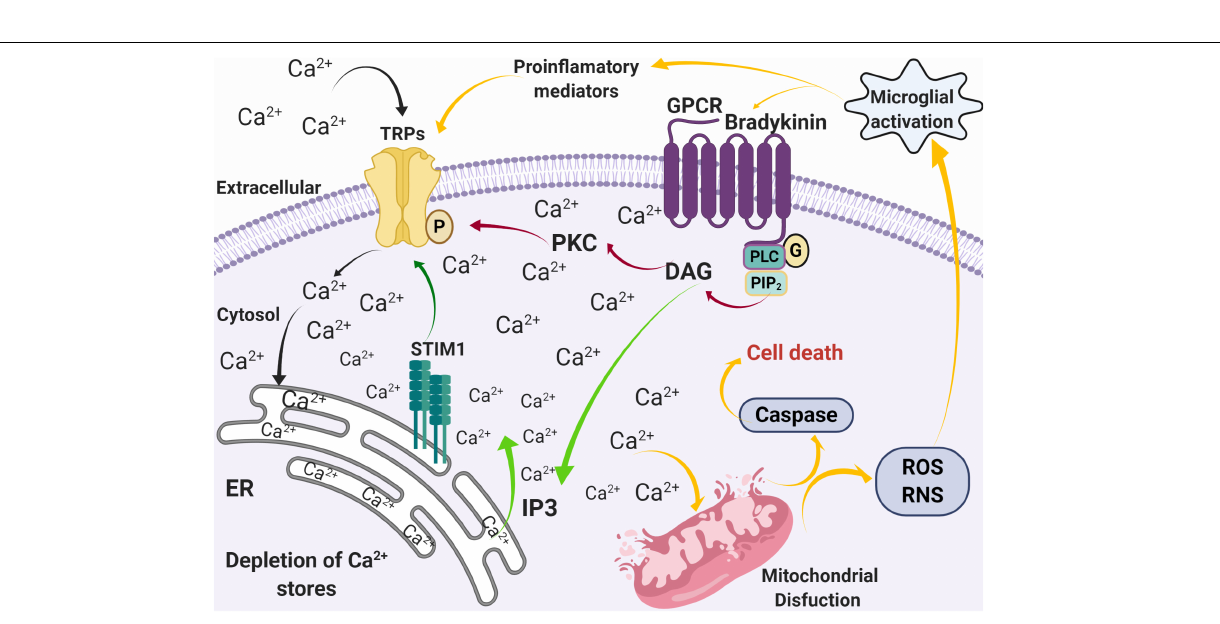
Frontiers in Neuroscience | www.frontiersin.org